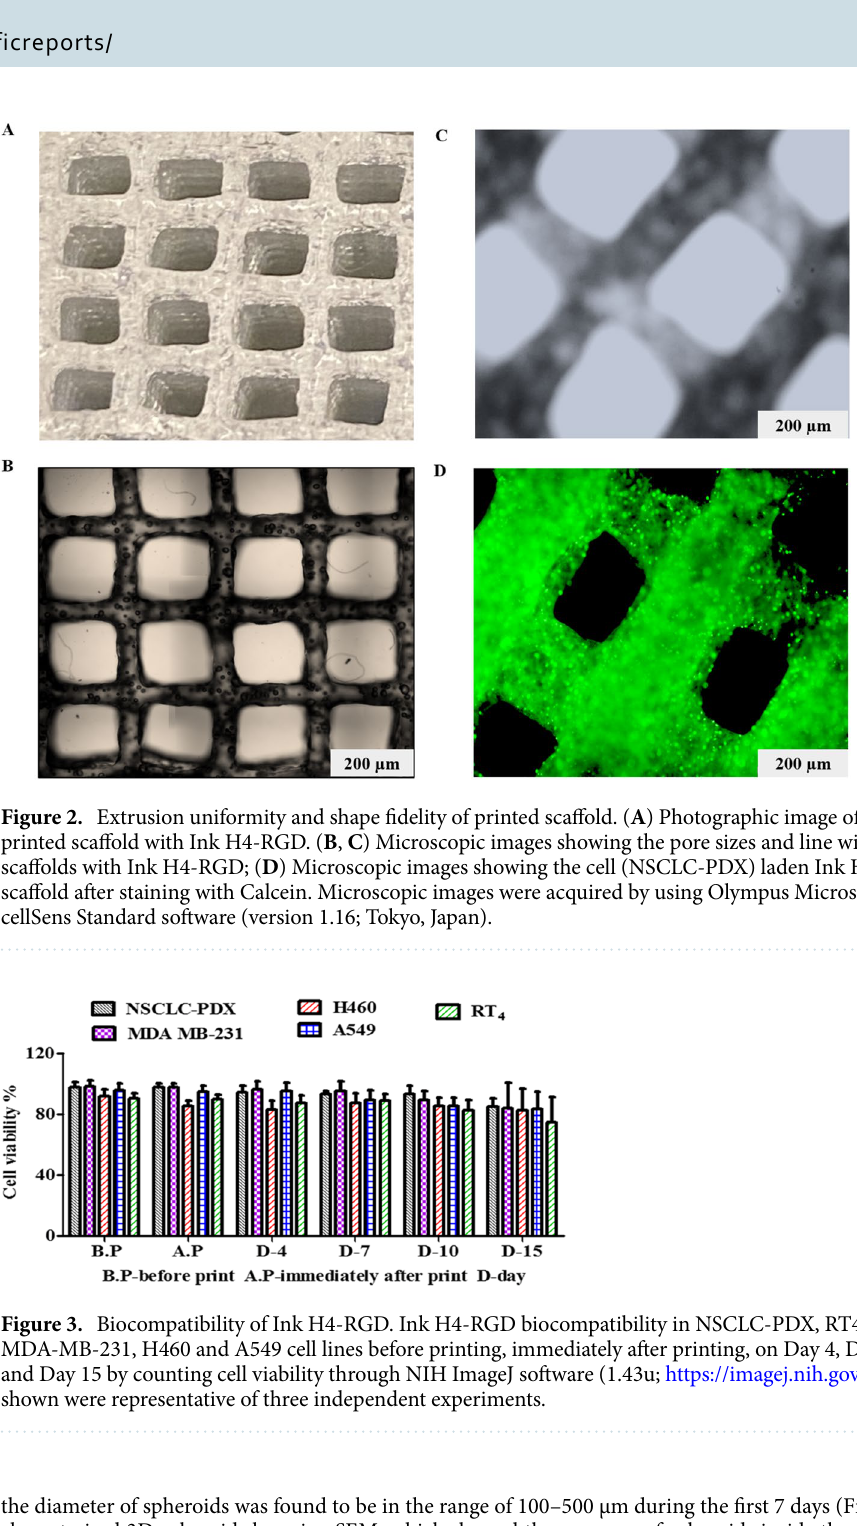
(MDA-MB-231WT, NSCLC-PDX and HCC-827), 3D spheroids showed more resistance to DTX, erlotinib and